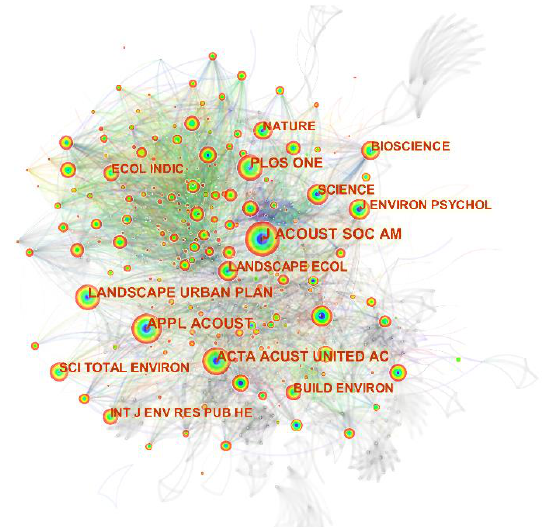
Figure 4. A network map showing journal co-citation in soundscape research. Table 2 portrays the top 10 most-cited journals in the field of urban soundscape re- search. “The Acoustical Society of America “(1290 times) topped the list, followed b y “Ap- plied Acoustics” (864 times), “Landscape and Urban Planning” (673 times) , etc. Core jour- nals are cited most frequently, indicating that they have published more in-depth and comprehensive research articles and are often cited by relevant academic circles. Table 2. Top 10 most-cited journals in the field of soundscape. No.